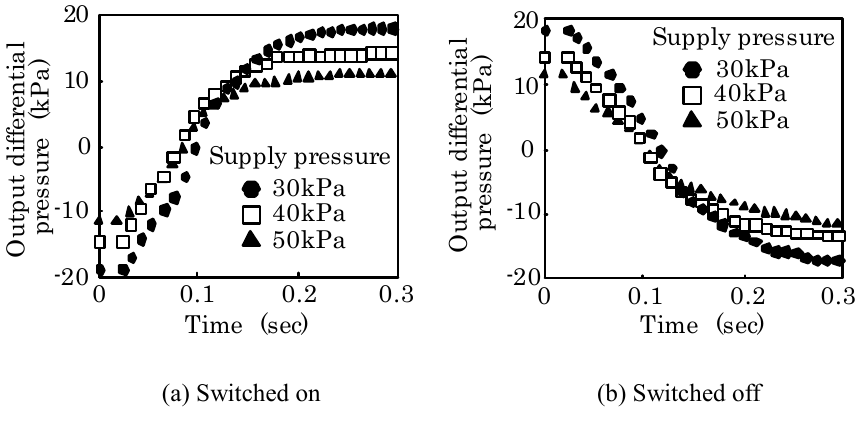
Step response of optical on/off device